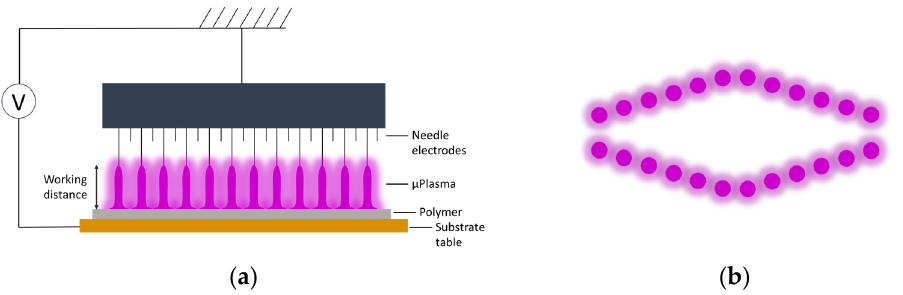
Figure 2. ( a ) Schematic of μ Plasma modification setup. ( b ) μ Plasma discharges pattern generated by 24 needle electrons from top view.